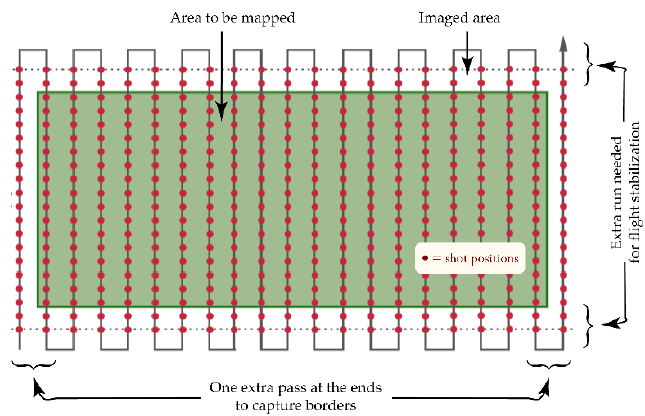
Figure 2. Typical UAV trajectory for an aerial survey (red dots identify shot positions).